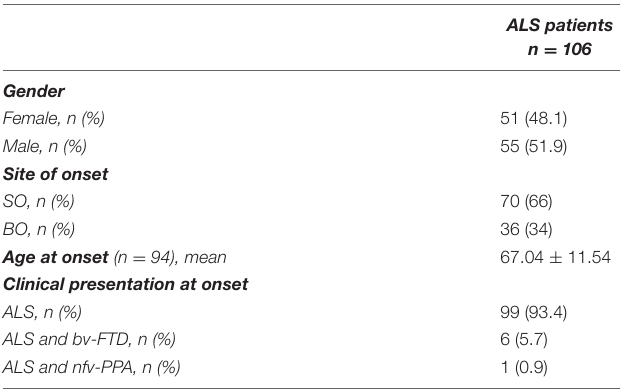
TABLE 1 | Clinical information of the Italian cohort of ALS